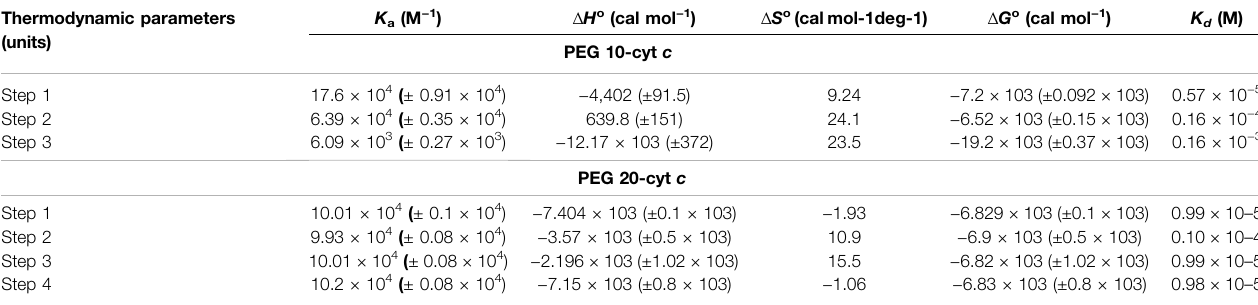
TABLE 3 | Calorimetric binding parameters estimated from ITC measurements on interaction of PEGs (PEG 10 and PEG 20 kDa) with cyt c at 298 K (25 ° C) a . Thermodynamic parameters